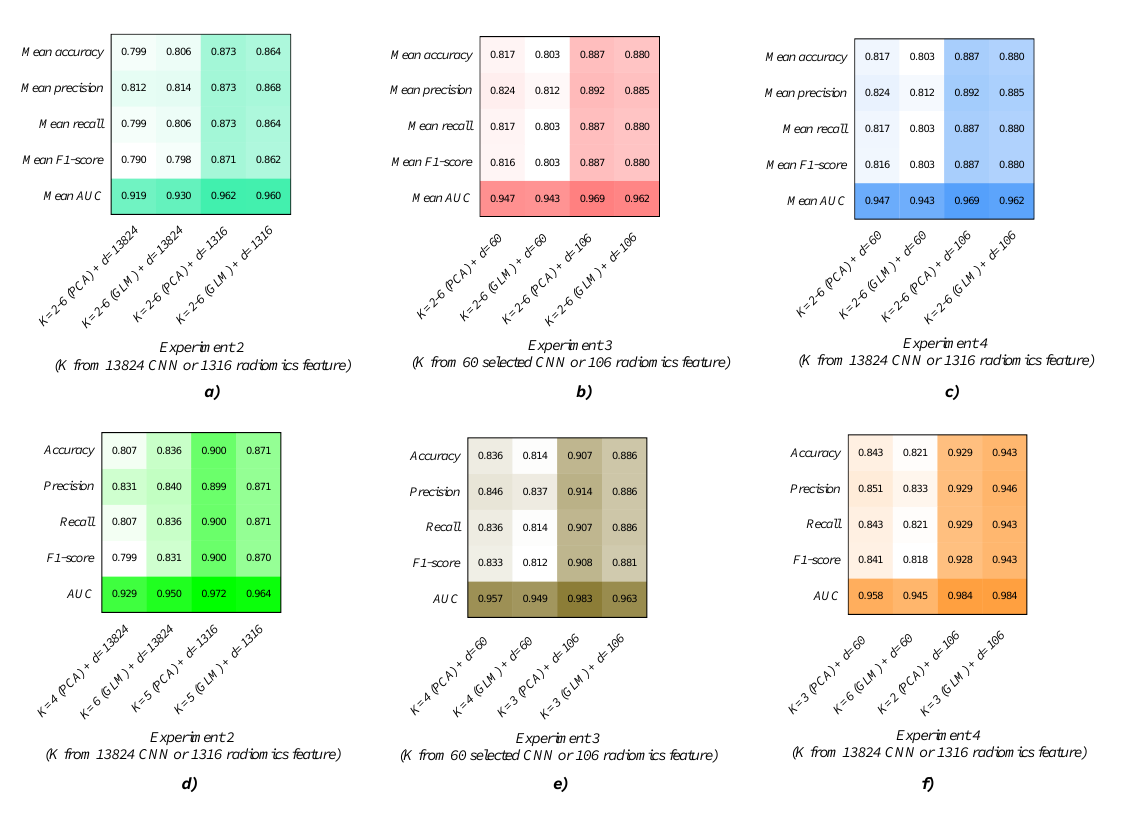
Figure 6. Visual evaluation metrics and ROC curves of the AMGNN classifier in Experiments 2 – 4. ( a – c ) The mean evaluation metrics, and ( d – f ) the best evaluation metrics.